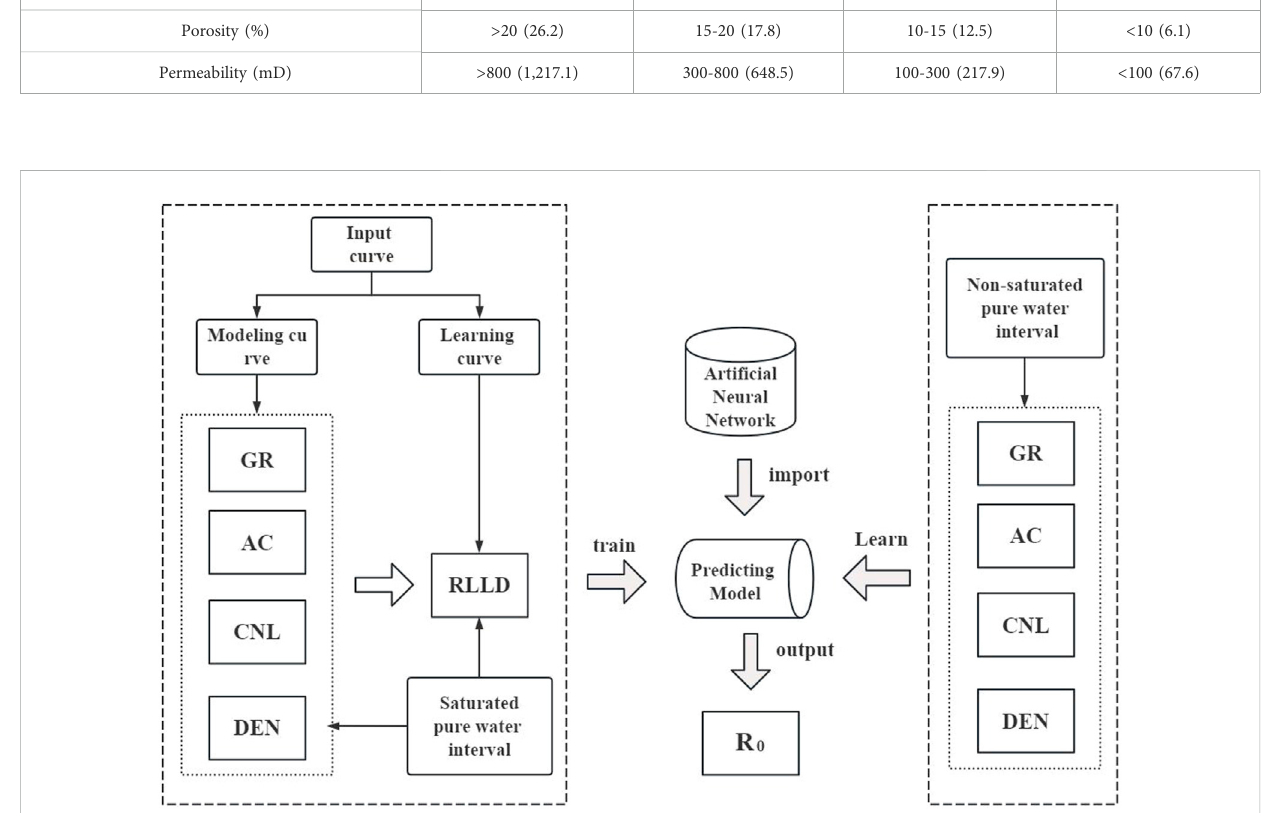
FIGURE 3 Architecture fi gure of R0 predicted by the arti fi cial neural network.